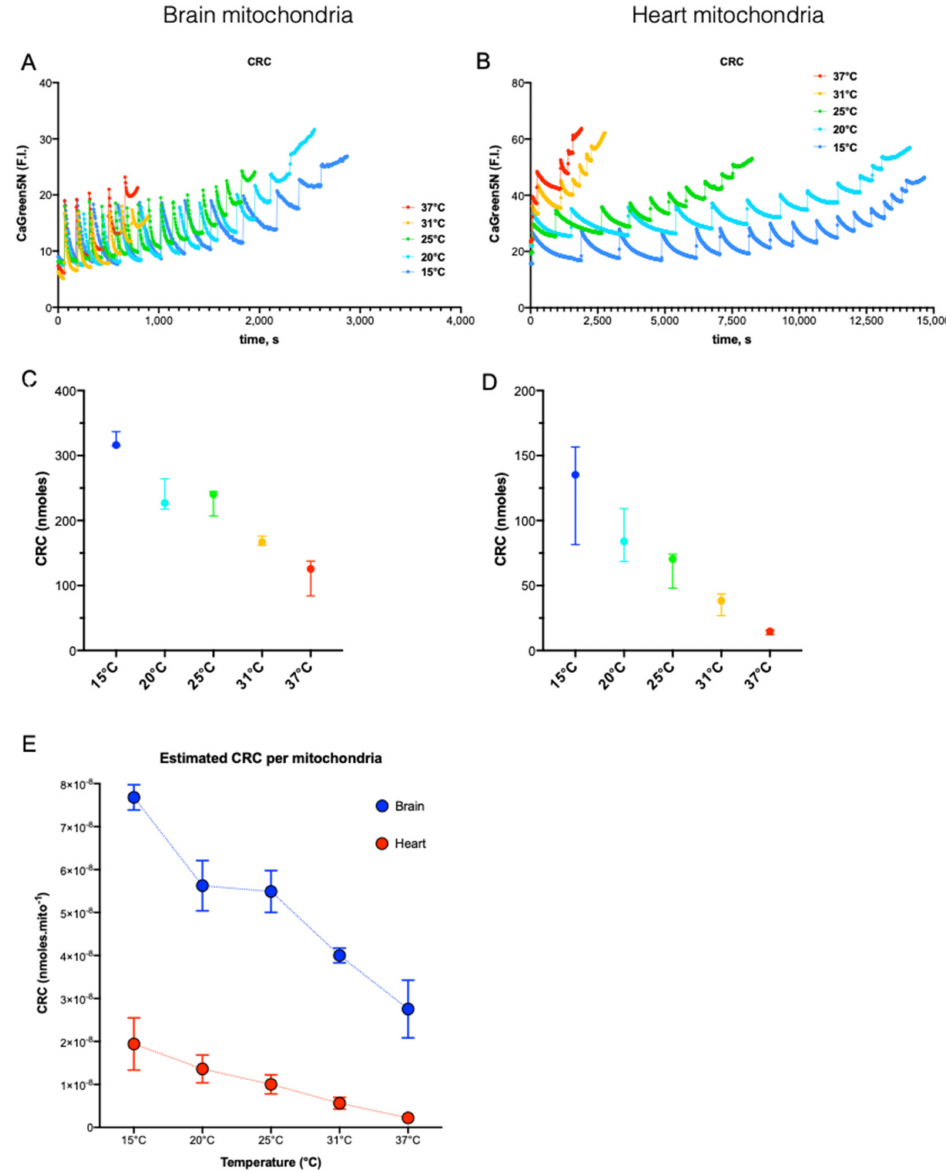
Figure 4. The dependance of Ca 2+ retention capacity on the temperature. Example of Ca 2+ retention capacity (CRC) traces for brain ( A ) and heart ( B ) at different temperatures. ( C , D ). CRC in nmol of Ca 2+ calculated by the calibration curve method at different temperature (15, 20, 25, 31, and 37 ◦